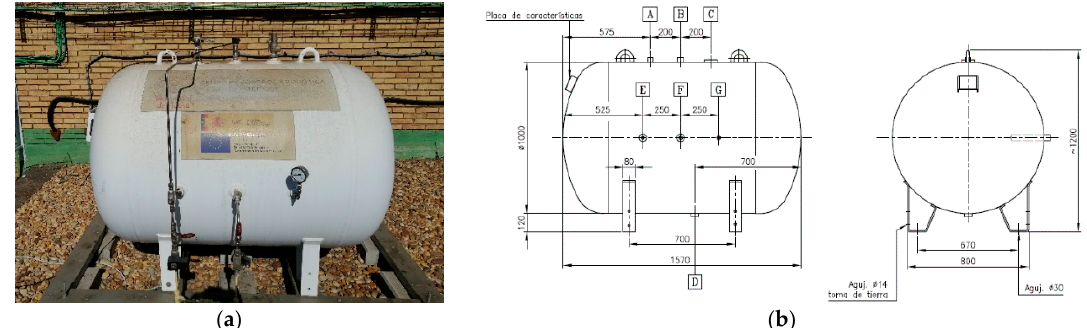
Figure 11. ( a ) Detail of the hydrogen compressed gas tank; ( b ) layout characteristics.